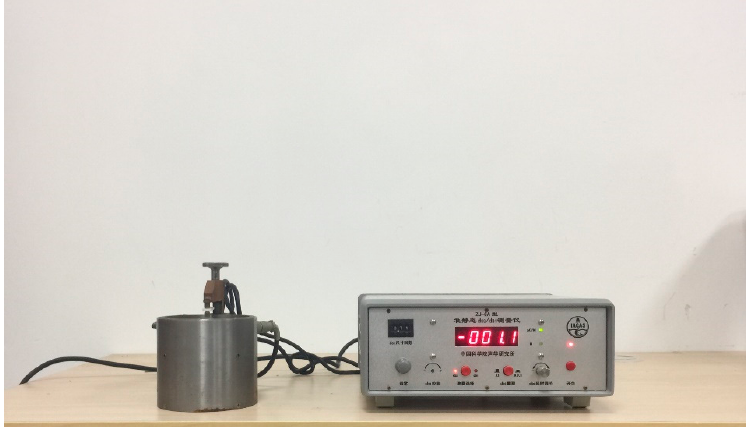
Figure 6. Piezometer.